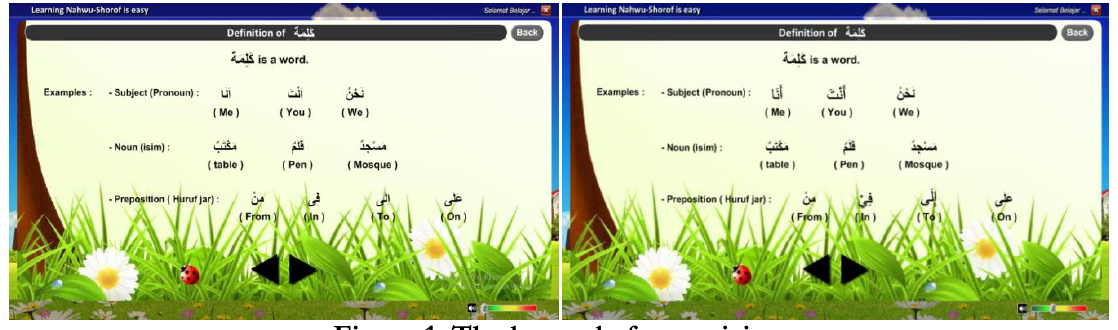
Figure 1. The layout before revision